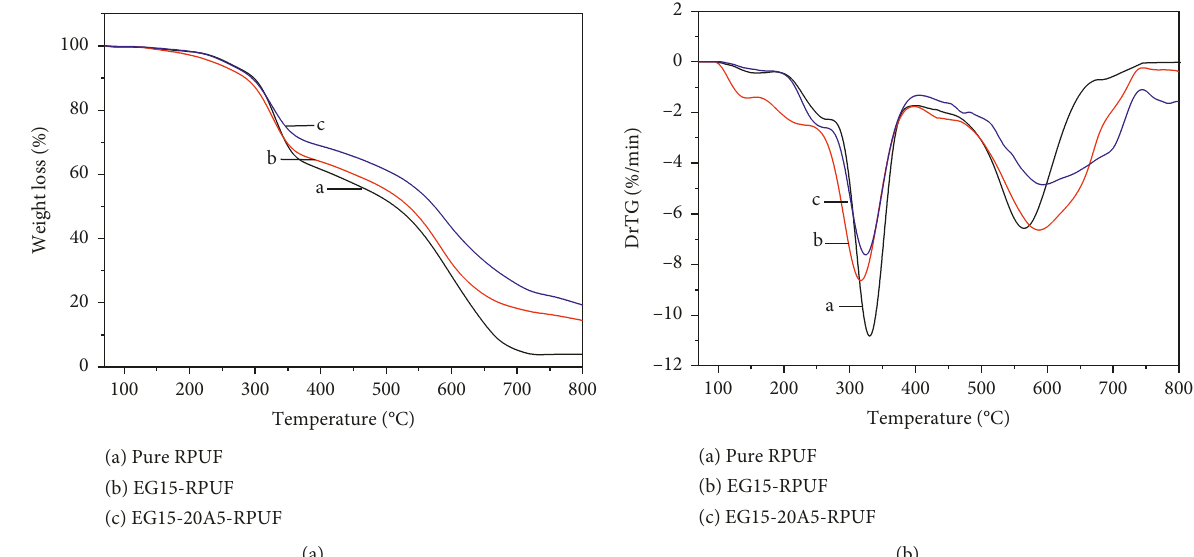
Figure 4: (a) TGA and (b) DTG curves of pure PU foam and the PU composites.